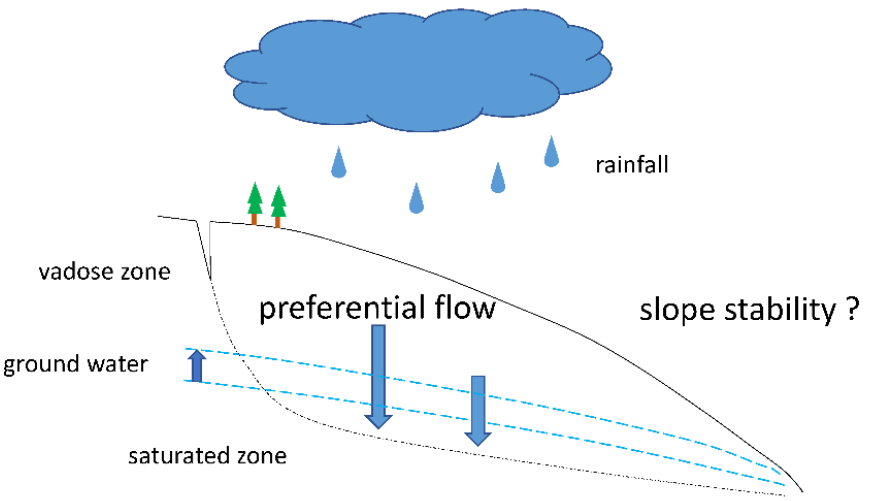
Figure 12. Influence of preferential flow on slope stability.